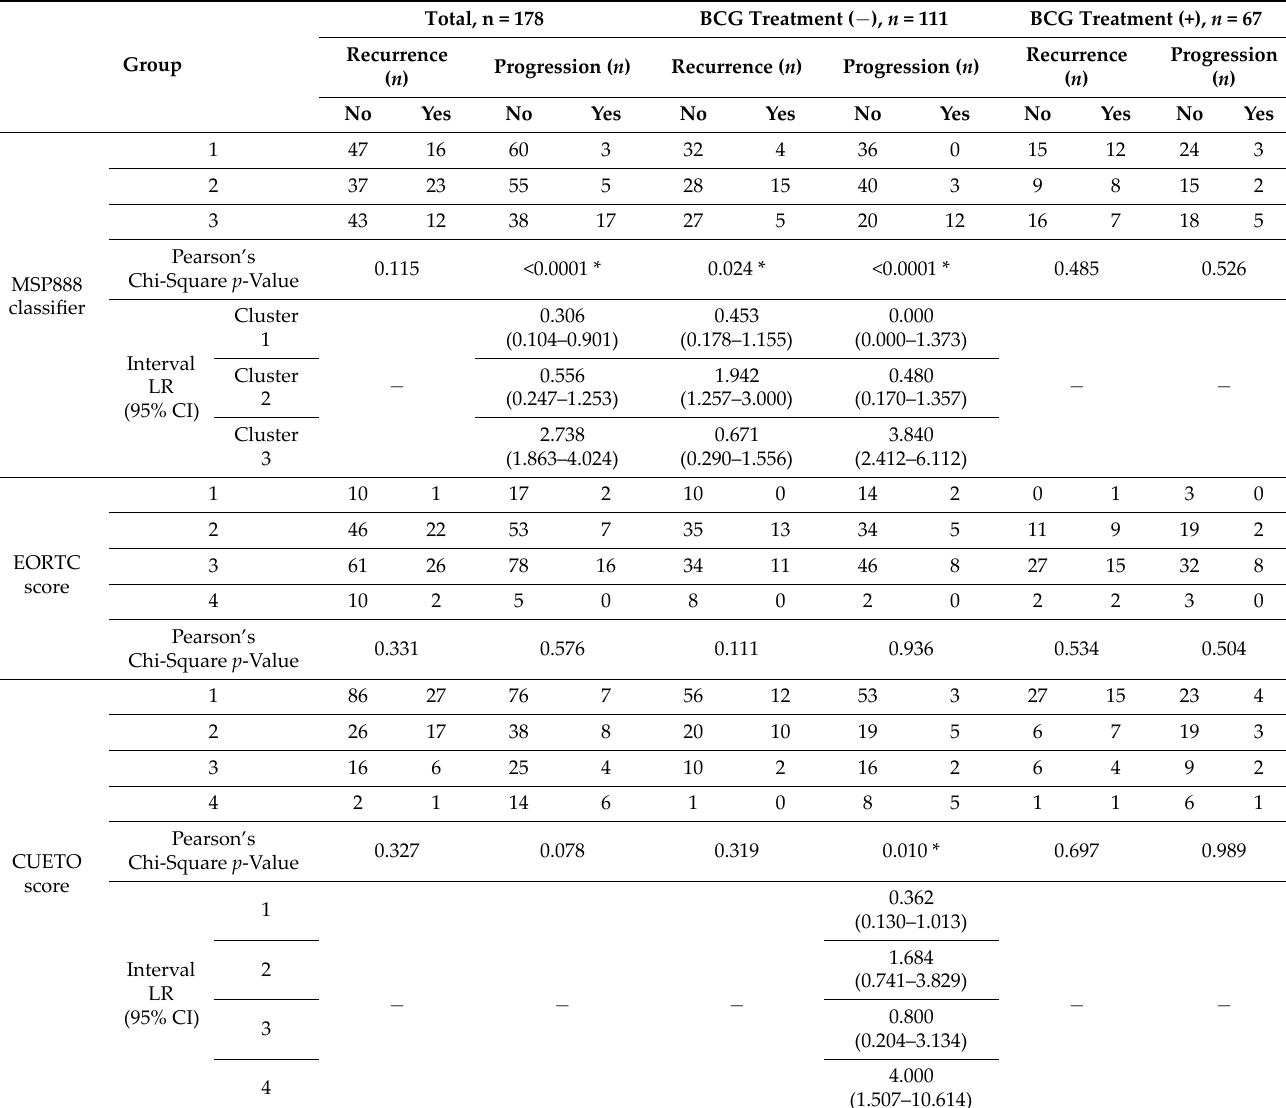
Table 1. Pearson’s Chi‑Square test for comparison of different risk estimators in the CBNUH